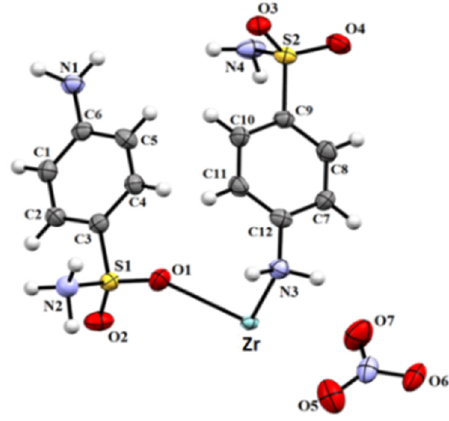
Figure 6: Asymmetric unit of the complex ( 1 ) : [ Zr ( C 12 H 17 N 4 O 4 S 2 ) 2 ] 2 + · 2 ( NO ) − . 3